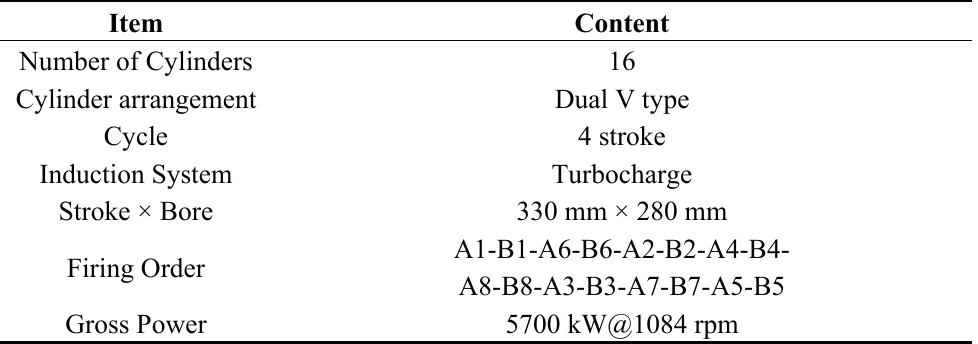
Figure 7. Setup view of cylinder A5. Table 3. Engine technical specifications.